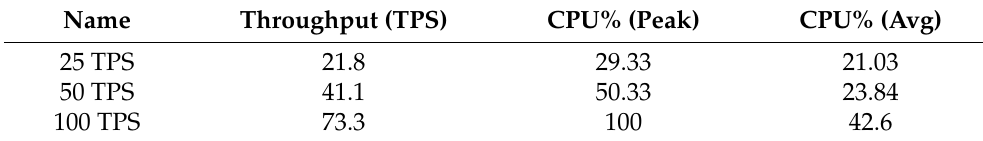
Table 4. Benchmarks over RPi3: throughput, CPU usage peak, and CPU usage